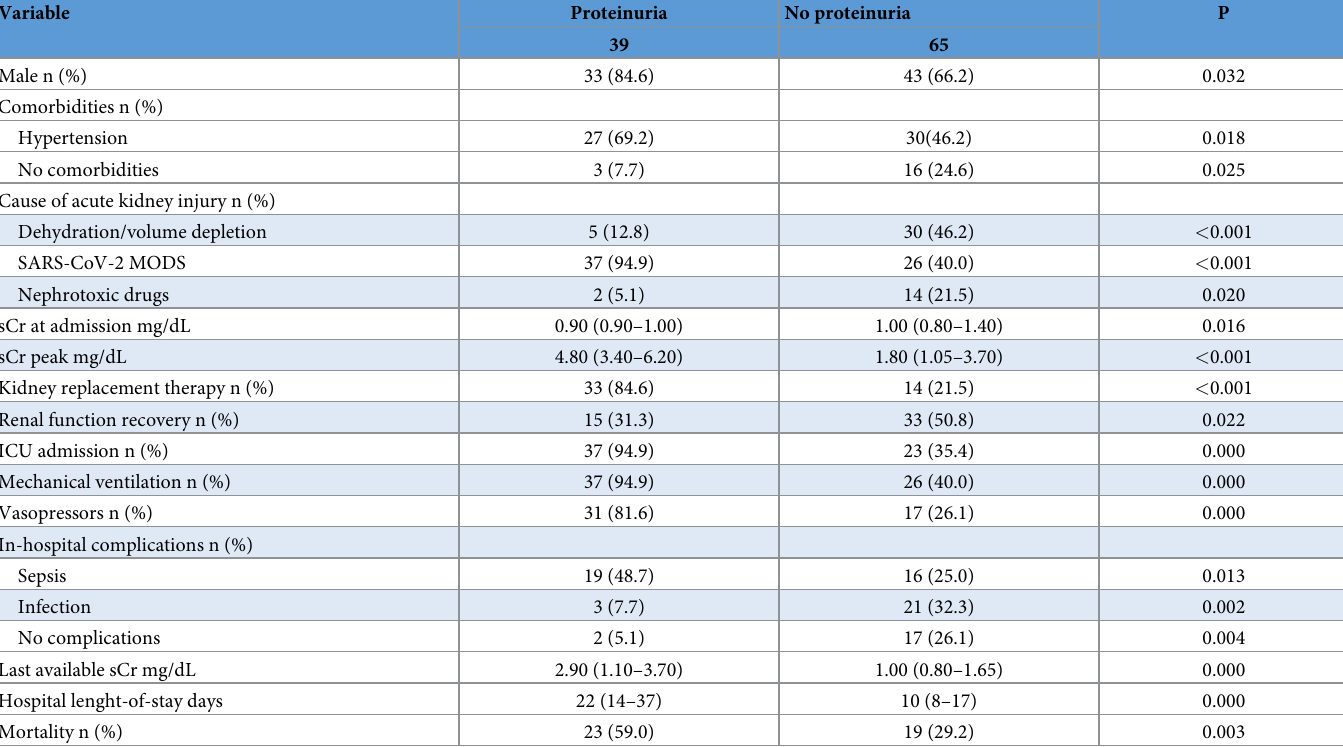
Table 5. Characteristics of patients who developed de novo proteinuria. Subgroup II. Variable